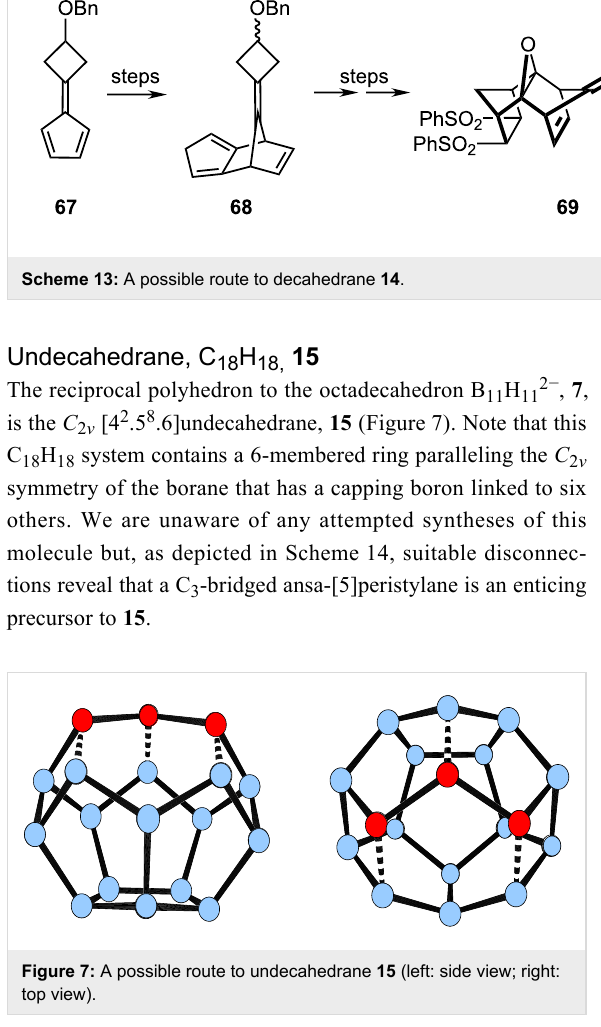
Highly symmetric inorganic